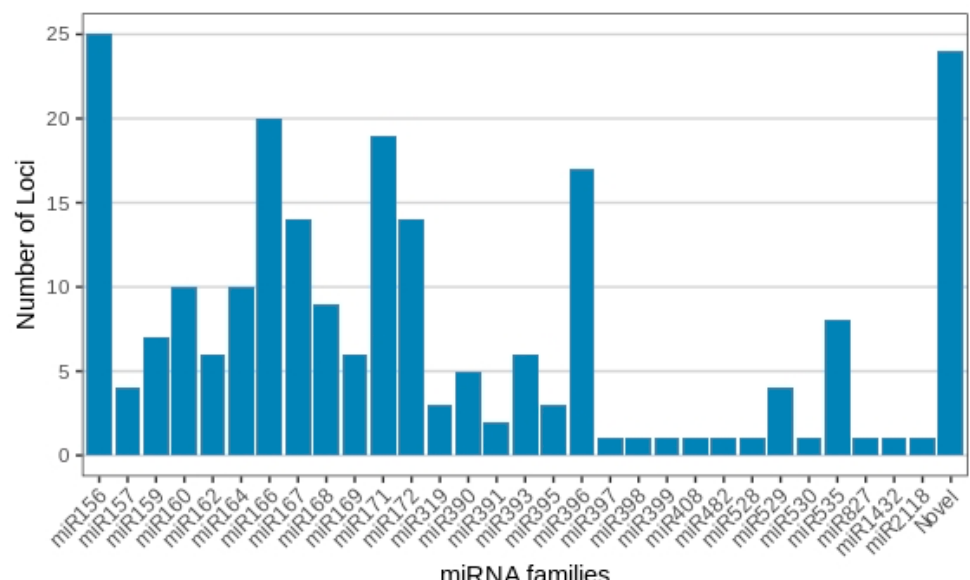
Figure 3. Musa acuminata var. Calcutta 4 miRNA families and member numbers observed in the small RNA libraries representing the four experimental treatments.